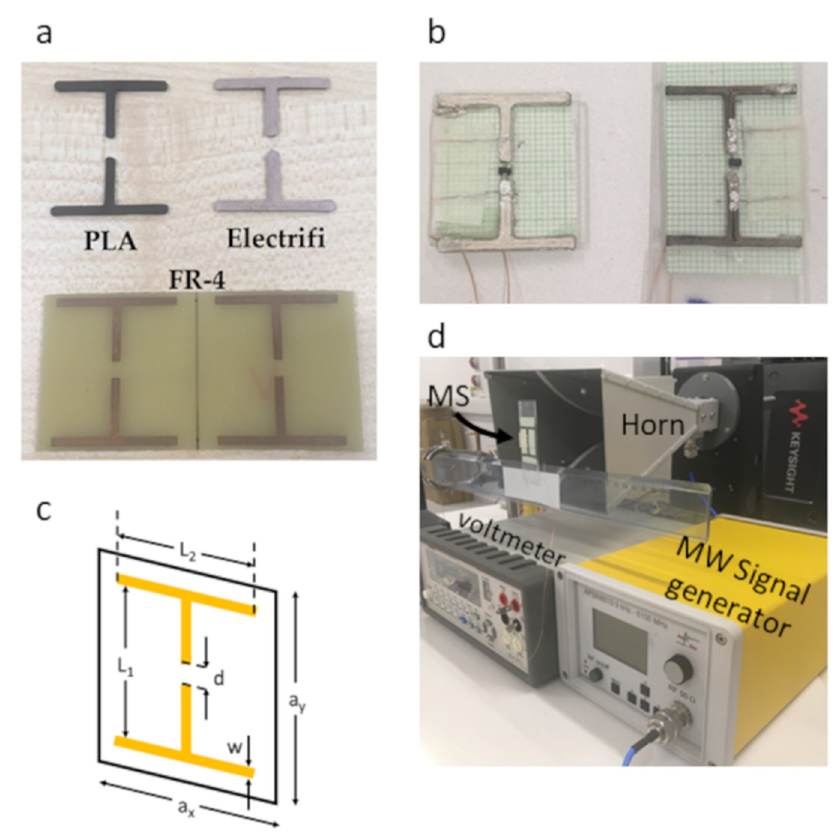
Figure 1. ( a ) FR-4 based metasurface (MS) units are demonstrated in the lower part of the picture. PLA (as-prepared) and Electrifi T-like, 3D printed components are shown above the FR-4 MS; ( b ) PLA/Ag and the Electrifi cut-wire MSs, used for energy harvesting experiments. The Schottky diode is clearly seen inside the MS gap; ( c ) dimensions of the MS unit; ( d ) experimental configuration, used for energy harvesting experiments. Table 1. Dimensions of the metasurface unit, as shown in Figure 1c.